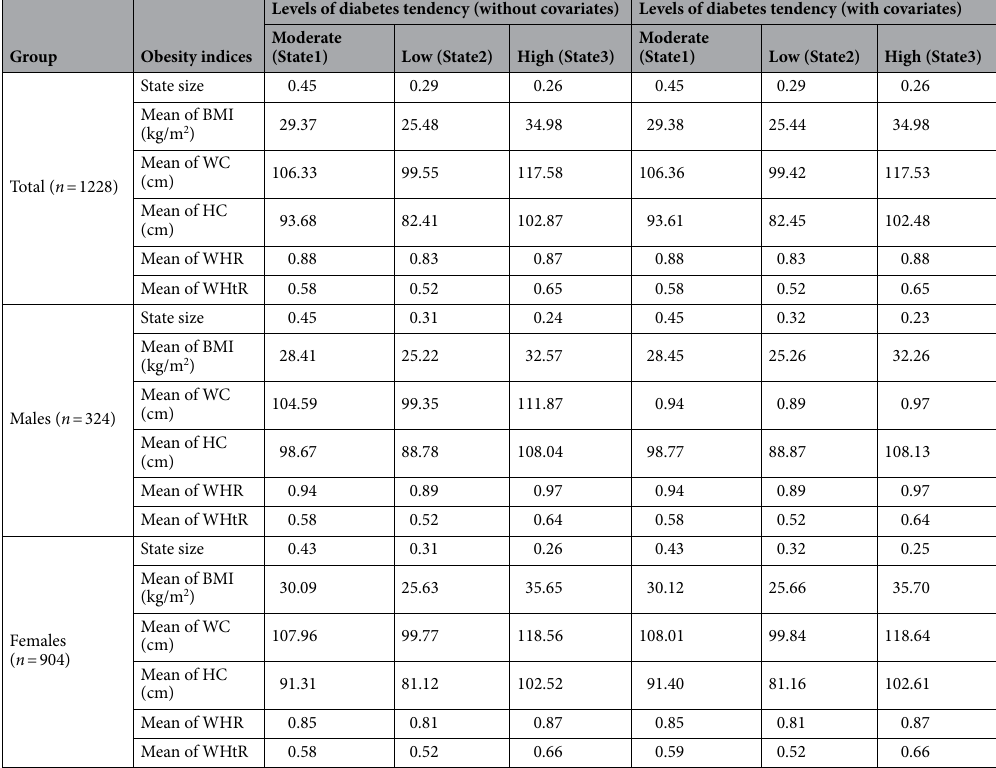
Table 3. The identified latent states of prediabetic subject resulted from latent Markov analysis. The covariates include: age, gender, marital status, educational level, smoking, physical activity, SBP, DBP, and lipid profile (CHOL, TG, HDL, and